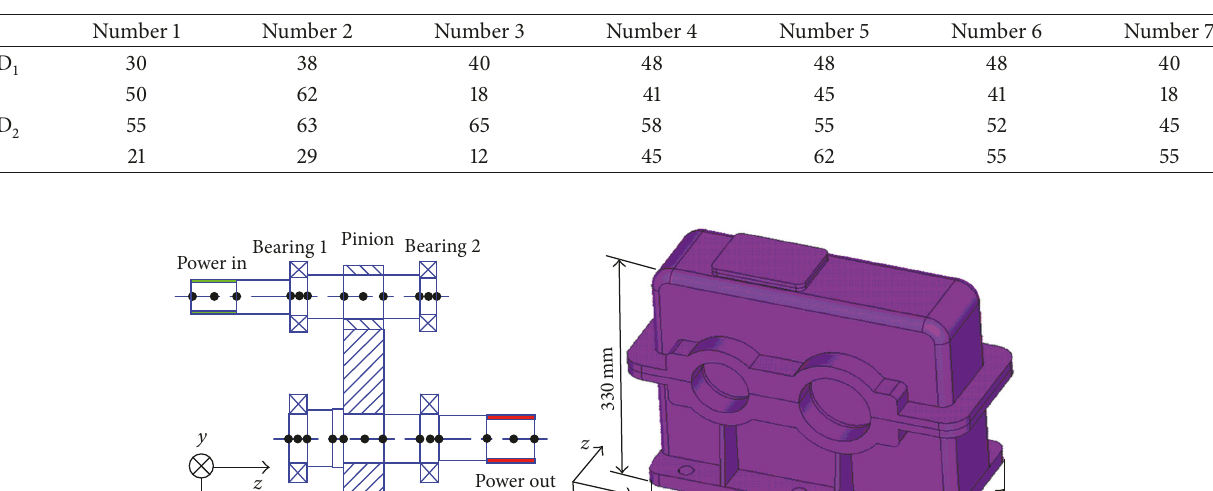
Table 2: Shaft segments dimensions (mm).